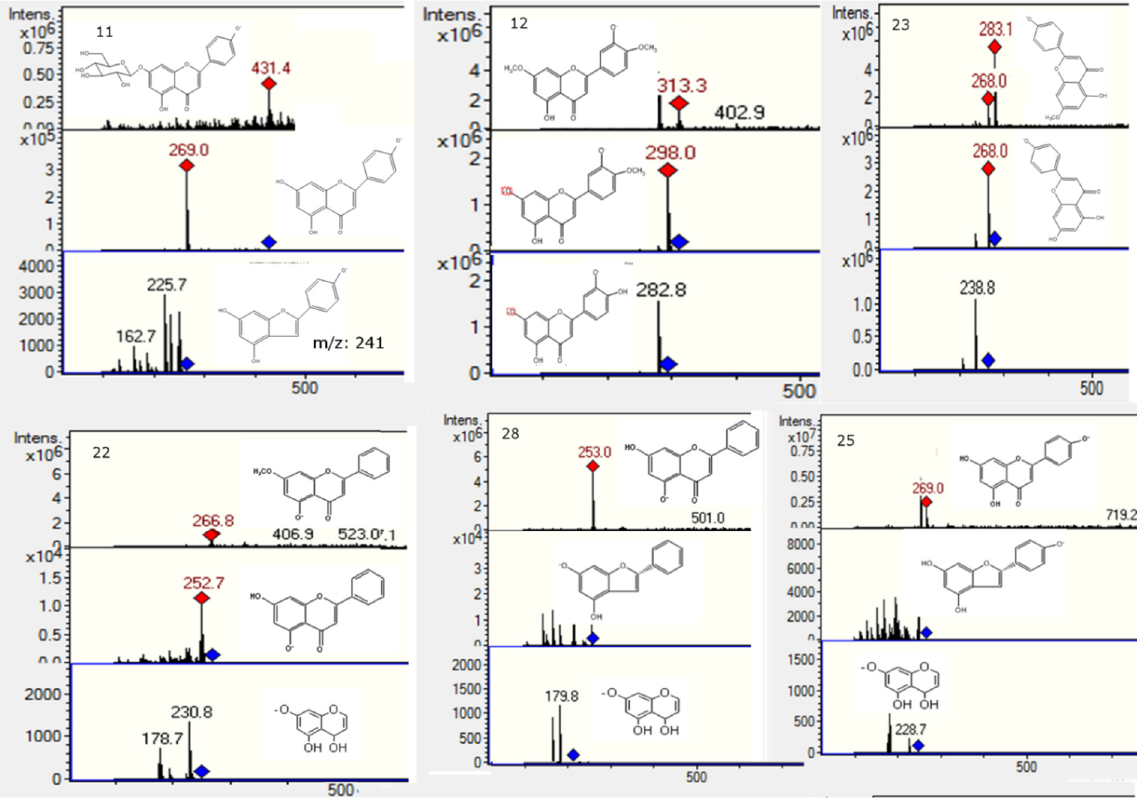
Figure 6. Structures, full scan MS and MS n spectra of Peaks 11 , 1 2 , 22 , 23 , 25 and 28